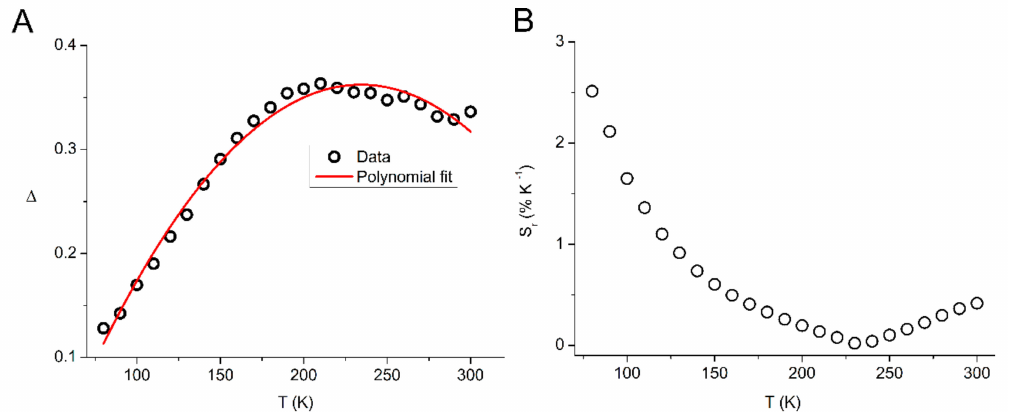
Figure 9. ( A ) The thermometric parameter versus temperature for material 7 . The red line represents a polynomial fit to the experimental data. ( B ) The S r parameter versus temperature for material 7 . See main text for